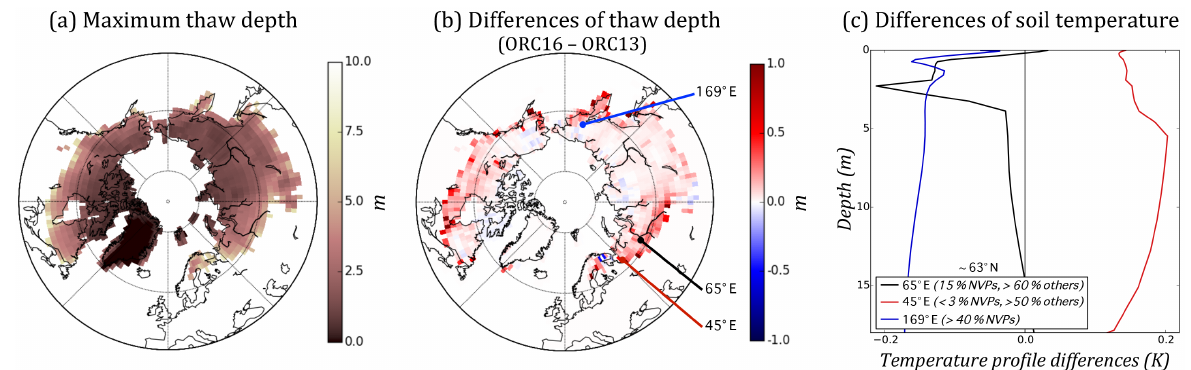
Figure 13. Map of (a) the maximum thaw depth (i.e. the active layer thickness or the maximum depth of the 0 ◦ C isotherm) for the simu- lation with 16 PFTs (ORC16); (b) differences between ORC16 and the simulation with 13 PFTs (ORC13) and (c) soil temperature profile differences (mean over 2004–2013) at three selected points (63 ◦ N and 45 ◦ E, 65 and 169 ◦ E) between ORC16 and